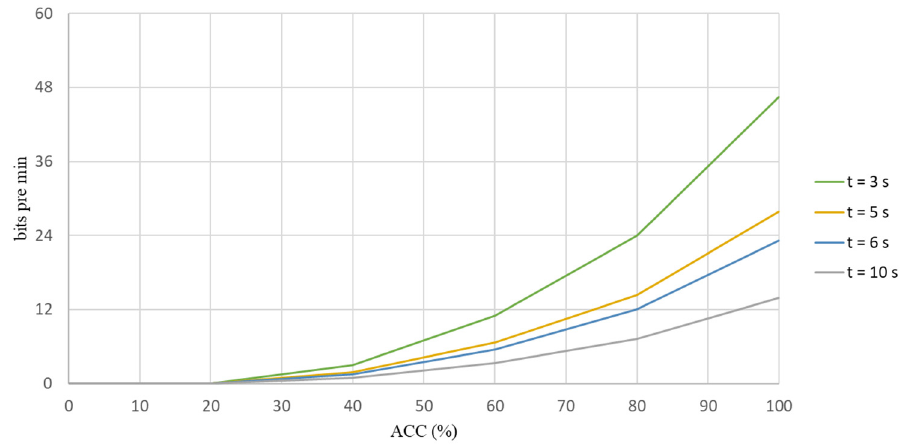
Figure 4. The information that is transferred rate in bits/trial for different average times for one